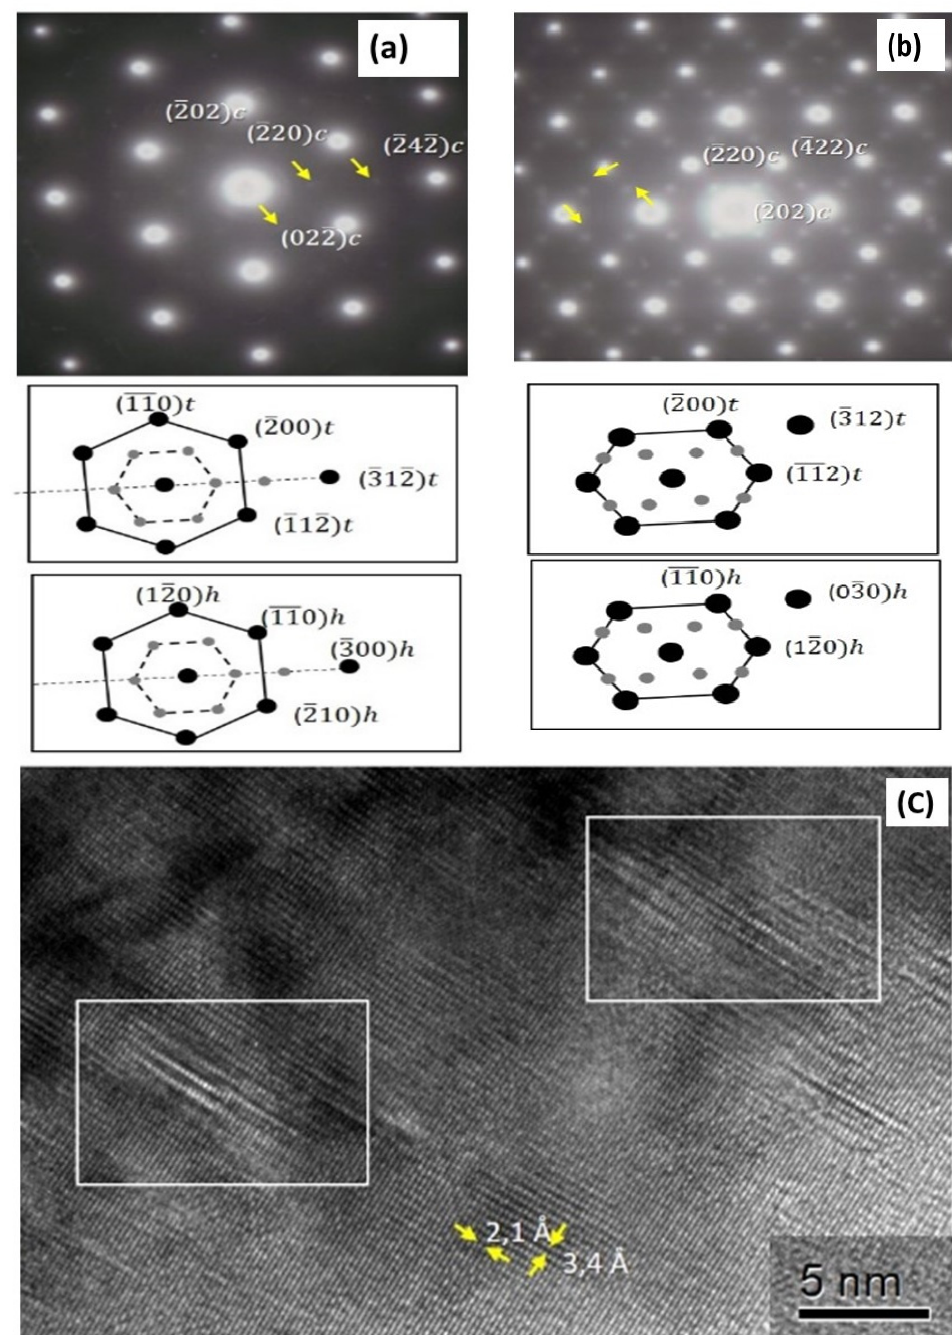
Figure 4. High-resolution transmission electron microscopy (HRTEM) study for AgSnBiSe 3 , showing ( a , b ) ED patterns along [111] c zone axis and schemes for different symmetries ( h and t refer to hexagonal and tetragonal, respectively), and ( c ) representative HRTEM image showing disorder regions apparent at the nanoscale.